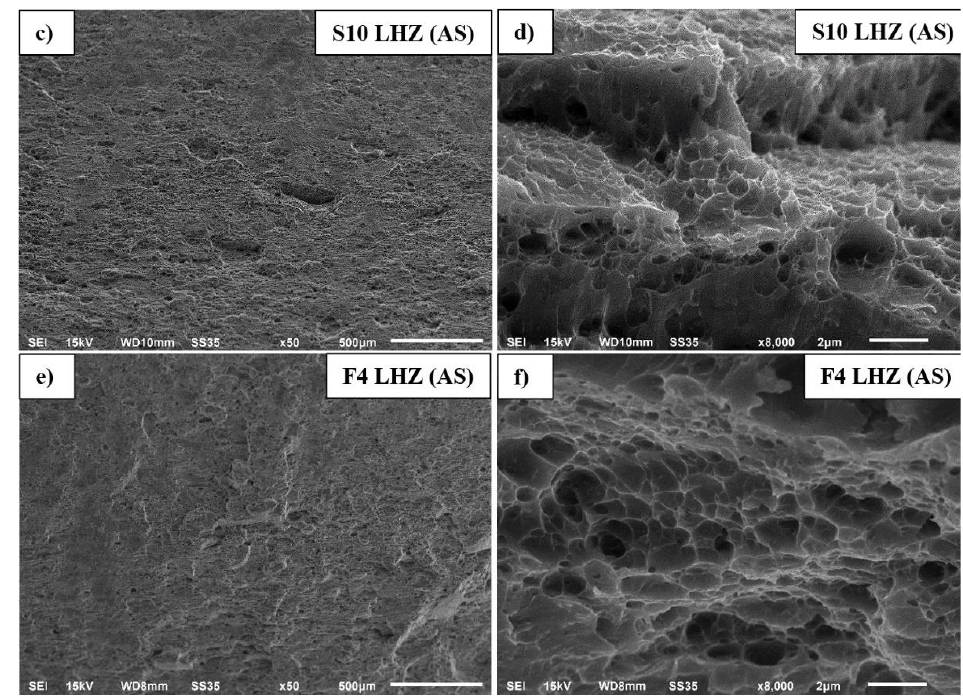
Figure 9. Fracture surfaces of tensile samples: BM ( a , b ), S10 ( c , d ) and F4 ( e , f